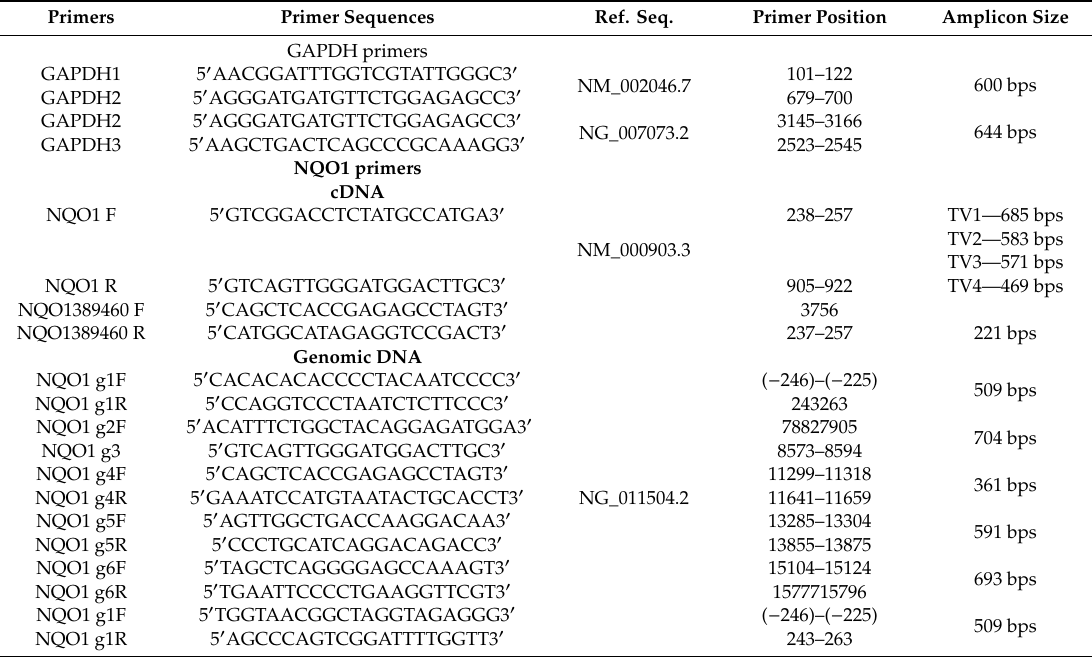
Table 1. The positions and composition of primers used for analyses of NQO